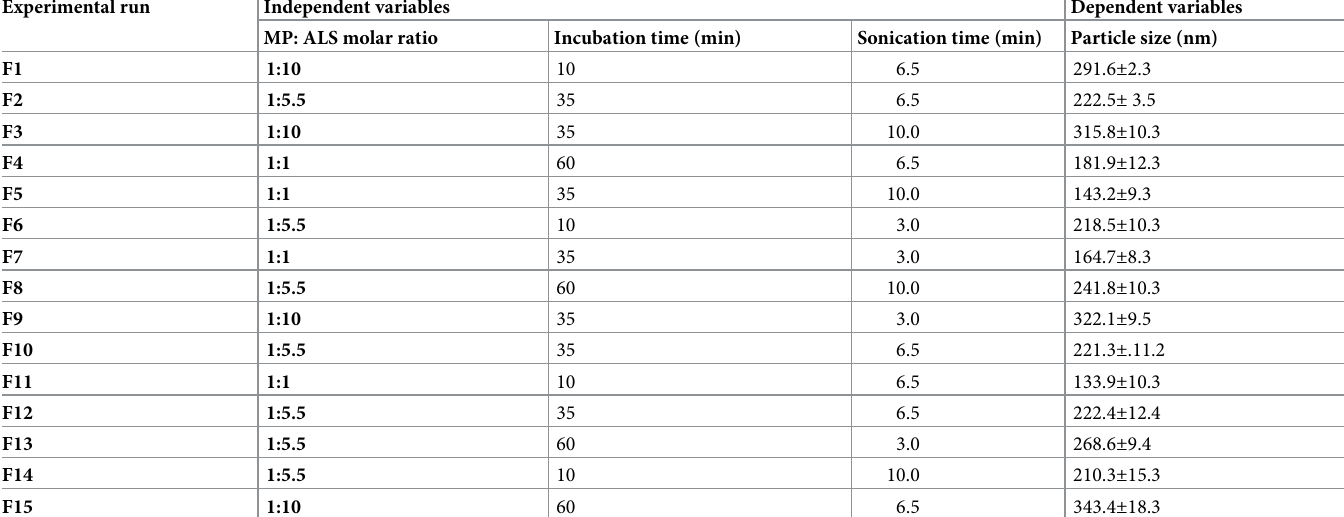
Table 2. Variables levels and observed response (particle size) for ALS-MP nanoconjugates experimental runs formulated according to Box-Behnken design generated. Experimental